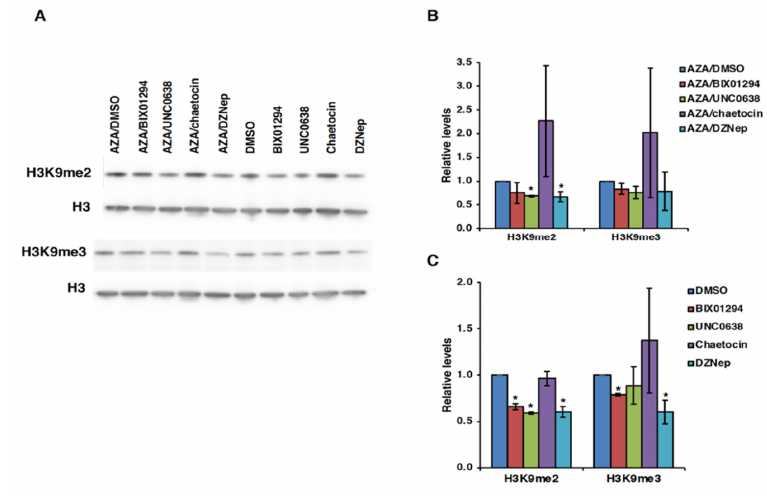
Figure 5. Western blot analyses for H3K9me2 and H3K9me3 in FXS cell line GM04025. ( A ) A representative western blot is shown. ( B , C ) Quantitation from three independent western blot experiments. Cells were treated with either HMT inhibitors alone or in combination with AZA as described in the legend for Figure 1 and Figure 3, respectively. Total cell lysates were prepared after 48 h treatment with HMT inhibitors alone or at day 5 after AZA/HMT inhibitor treatment. Total H3 levels were used for normalization. Error bars represent standard deviation, and statistically significant differences are indicated by an asterisk ( p < 0.05).